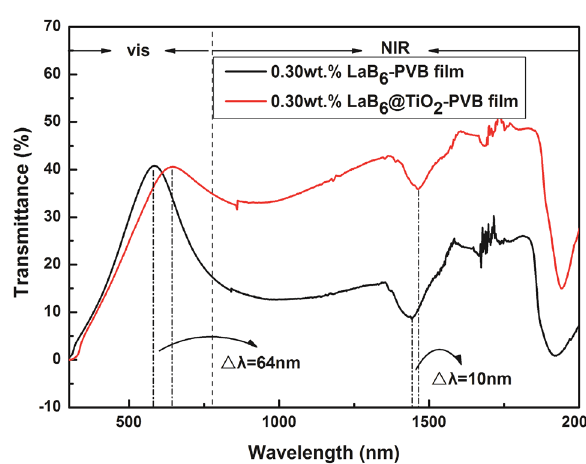
Figure 6: Transmittance spectra of composite fi